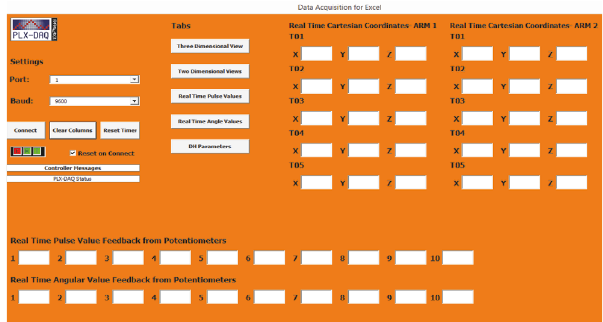
Figure 2: Graphical User Interface (GUI) for the “Teach and Playback” device